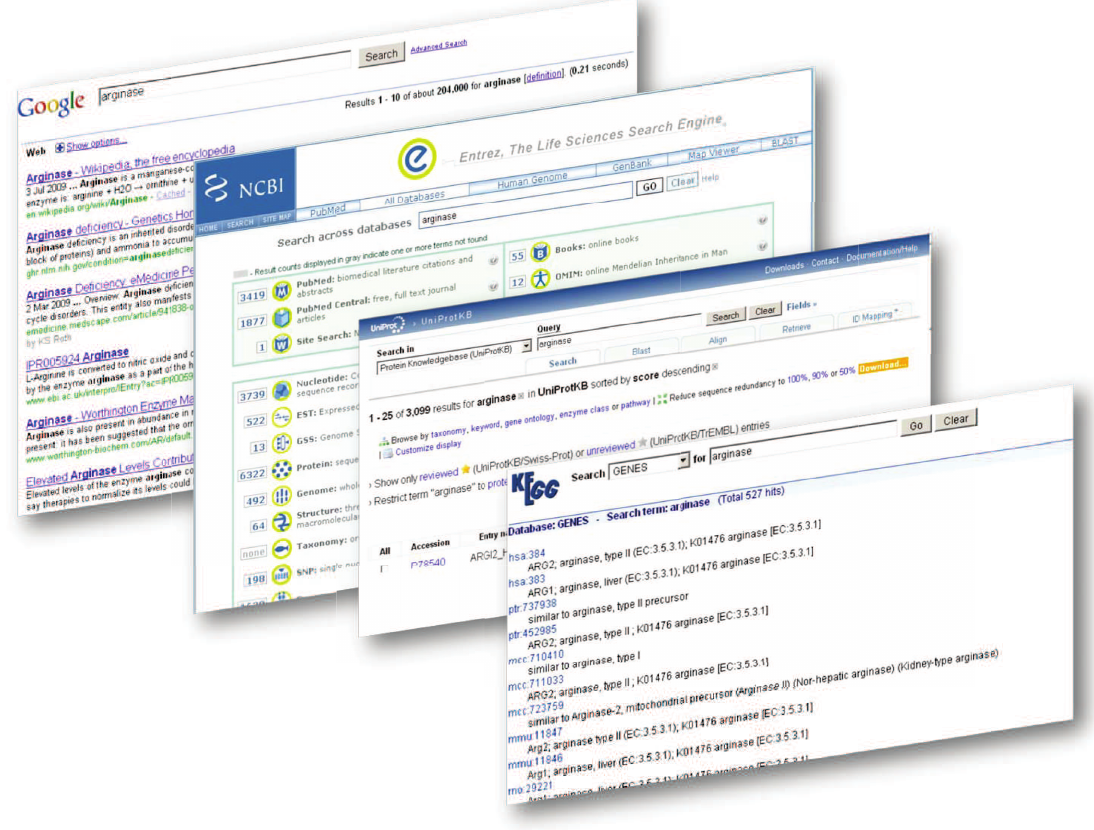
Figure 1: Search Engines in Life Science – the screenshots show examples of popular search en- gines, to investigate protein function: Google, Entrez, UniProt and